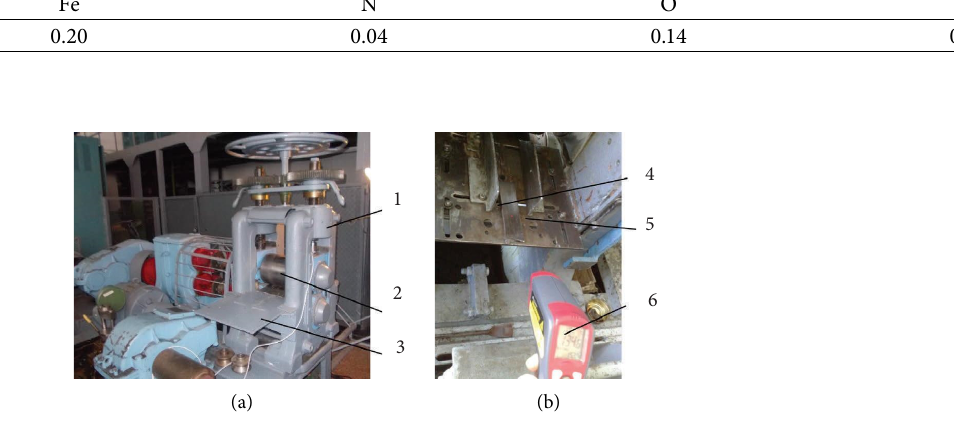
Figure 1: General view of rolling mill 260 (a) and the working stand with wiring (b).